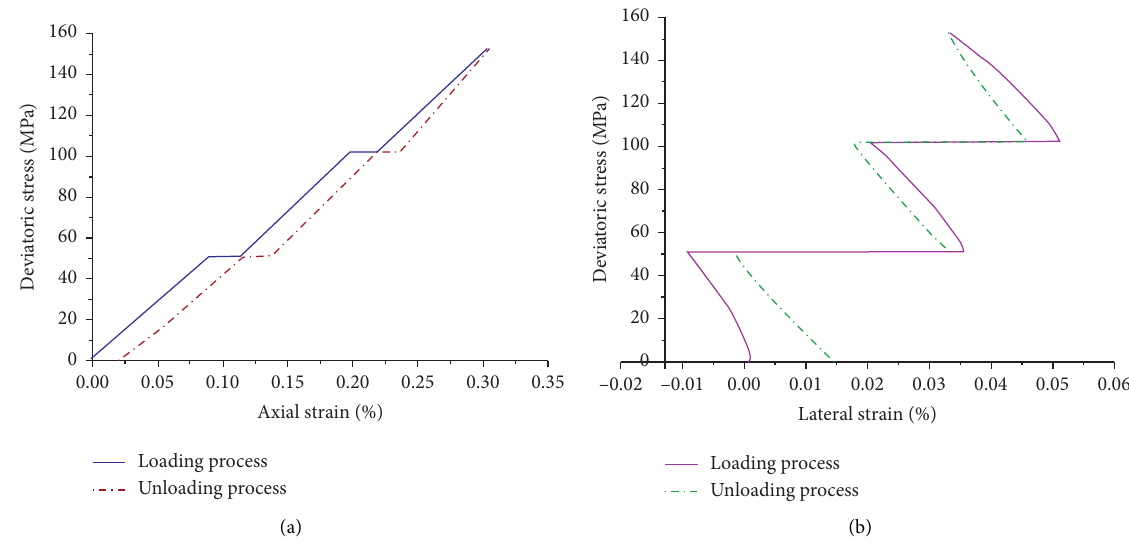
Figure 10: Typical stage loading and unloading testing curve. (a) Axial time-delay strain. (b) Lateral time-delay strain.